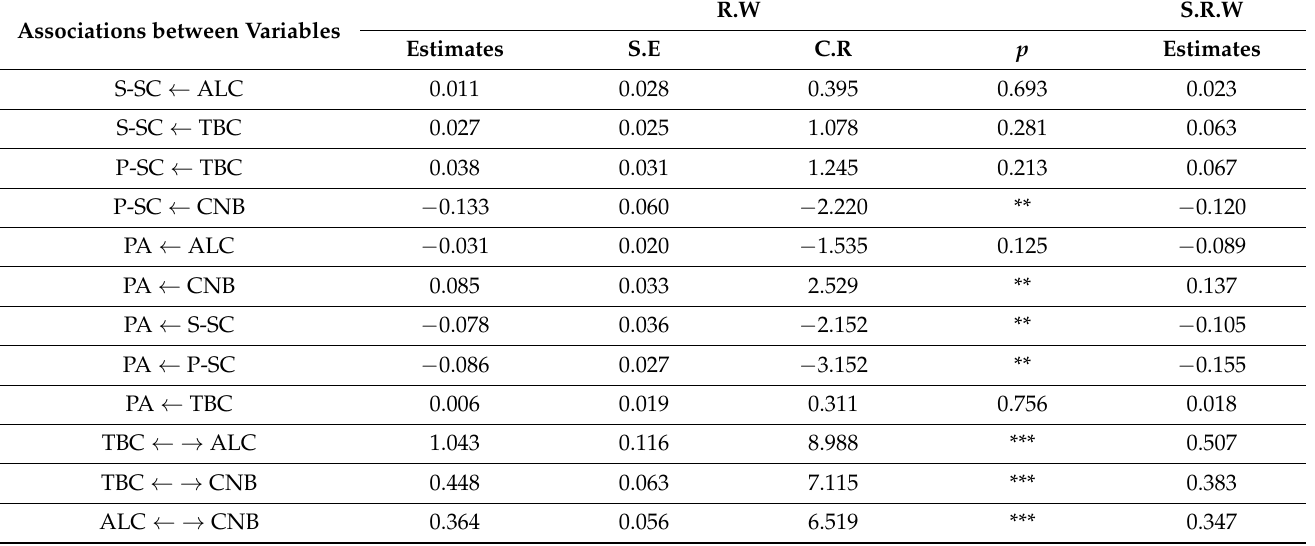
Table 6. Structural model for the female population.